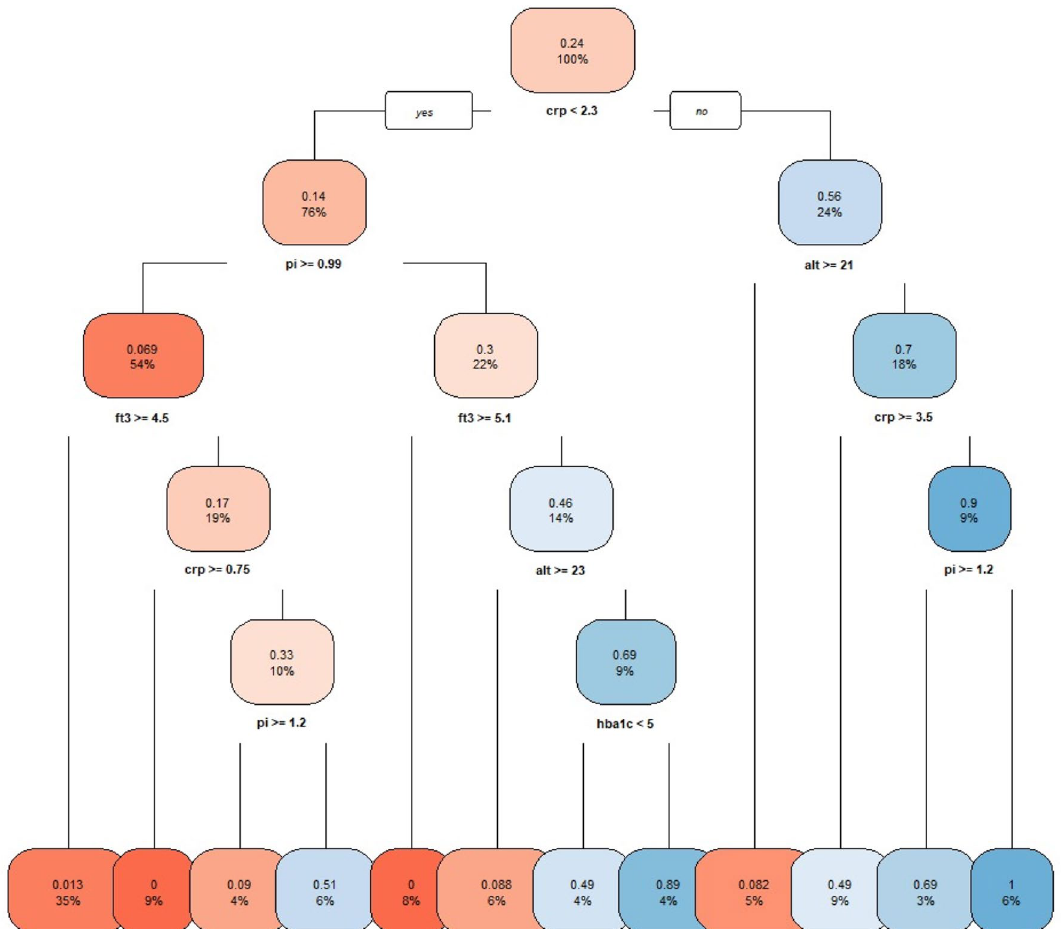
Figure 3. Regression tree of using Pi + LDH + HS − CRP + FT3 + ALT + HbA1c and the R function rpart::rpart. Color blue = ” responders” and color red = ”